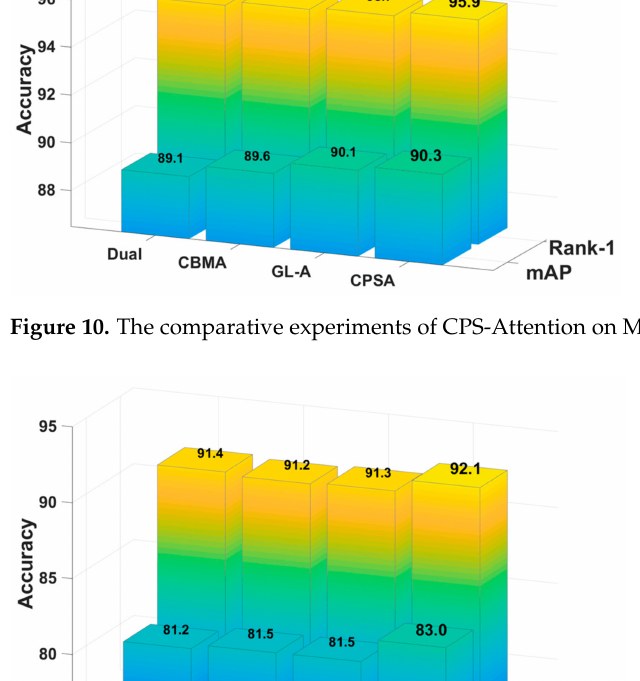
Figure 9. The Rank-1 of DBA-Net on three datasets.